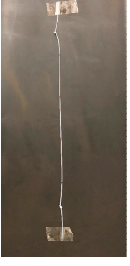
Figure 3. One of the nylon specimens.